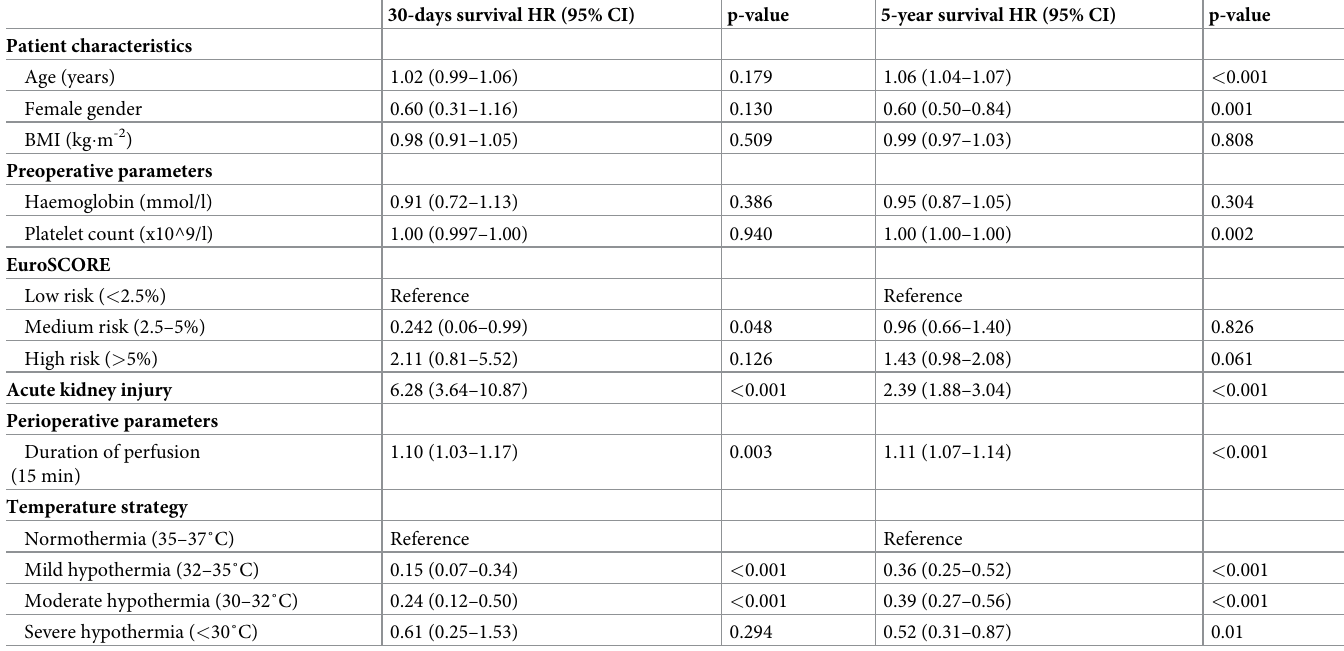
Table 2. Multivariate COX regression